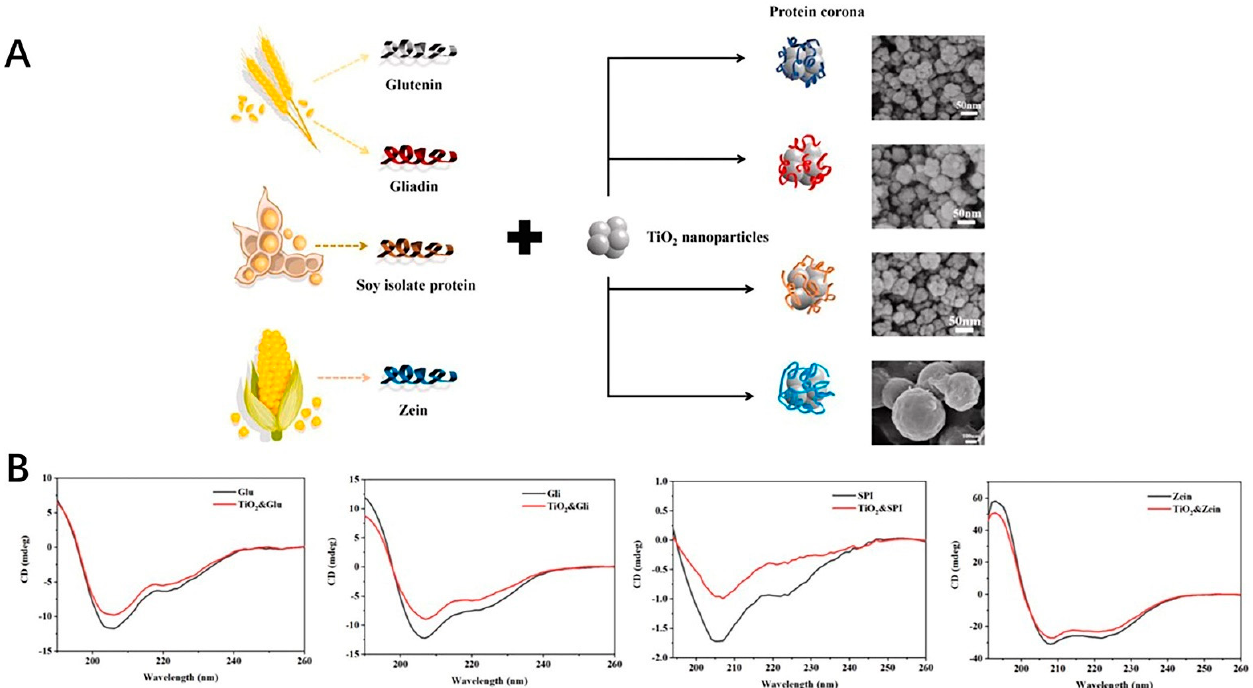
Figure 5. ( A ) The formation of the corona around the TiO 2 nanoparticles with the protein from foods. ( B ) CD spectra of protein (glutenin, gliadin, soy protein isolate, zein) and protein − nanoparticle co- ronas.